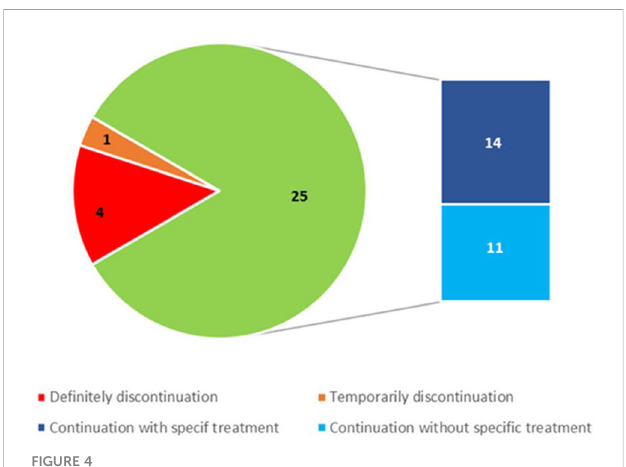
FIGURE 4 Number of treatment discontinuations or continuations with or without speci fi c therapy after kidney